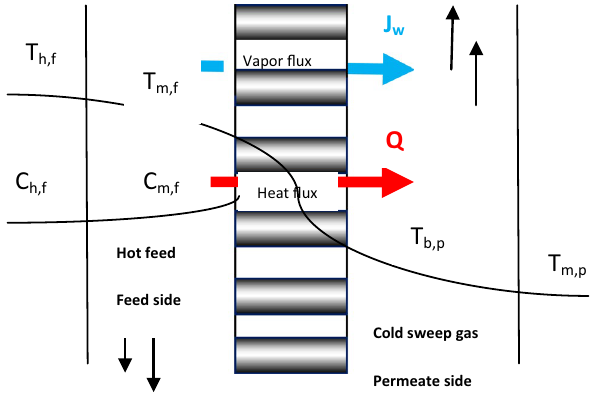
Fig. 7 Working principle of